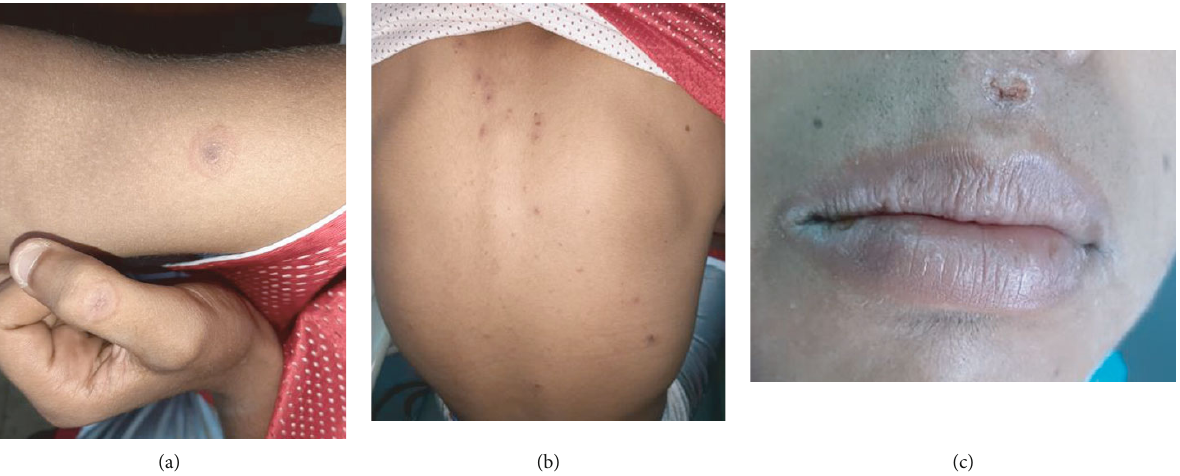
Figure 4: Clinical presentation of EM: (a) target lesions on the right arm and left thumb; (b) target lesions on the back; (c) crusty